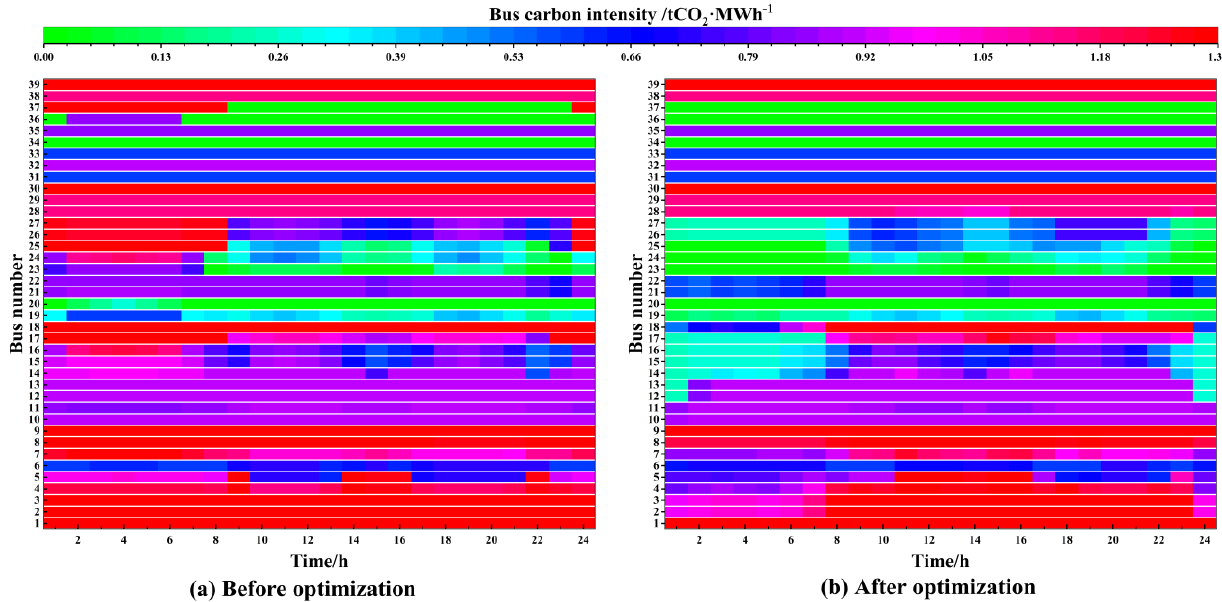
Figure 9. The bus intensities of each load before and after optimization.